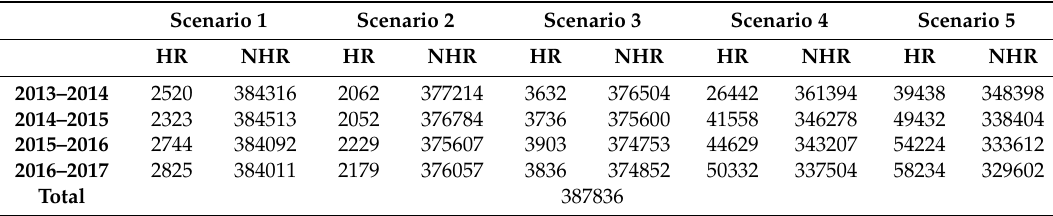
Table 1. Basic statistics of high-risk/non-high-risk